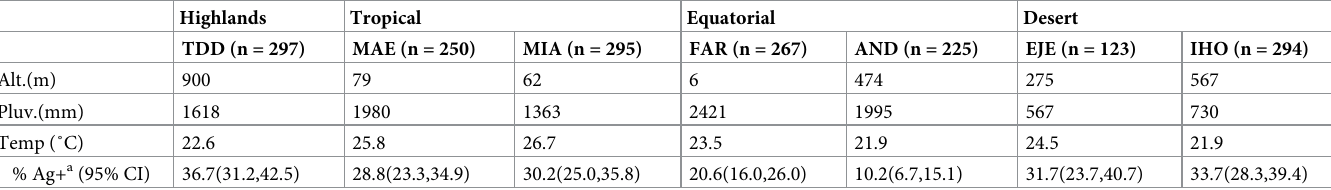
Table 1. Geo-climatic data and Taenia solium antigen prevalence assessed by B158/B60 Ag-ELISA of 7 sampling sites in Madagascar. Highlands